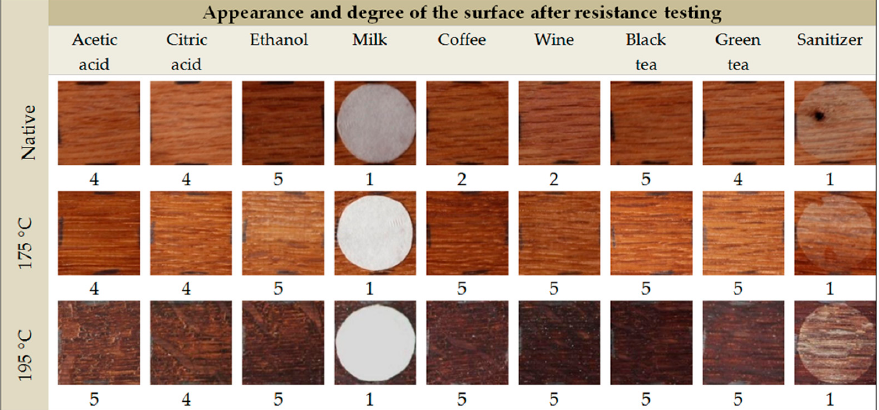
Figure 7. Resistance to cold liquids (degree): linseed oil surface finish.